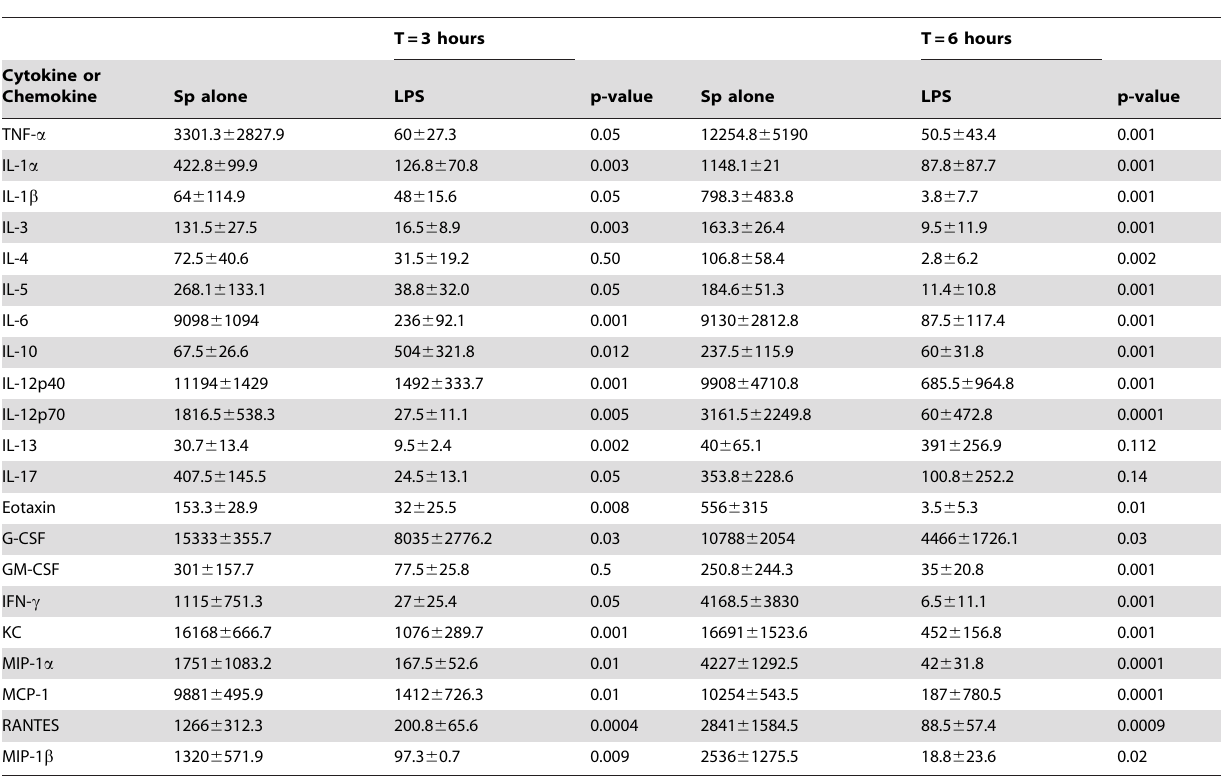
Table 1. Mean serum concentrations of cytokines and chemokines at 3 and 6 hours after bacterial challenge in LPS pretreated and PBS pretreated control mice (n= 7–10 per